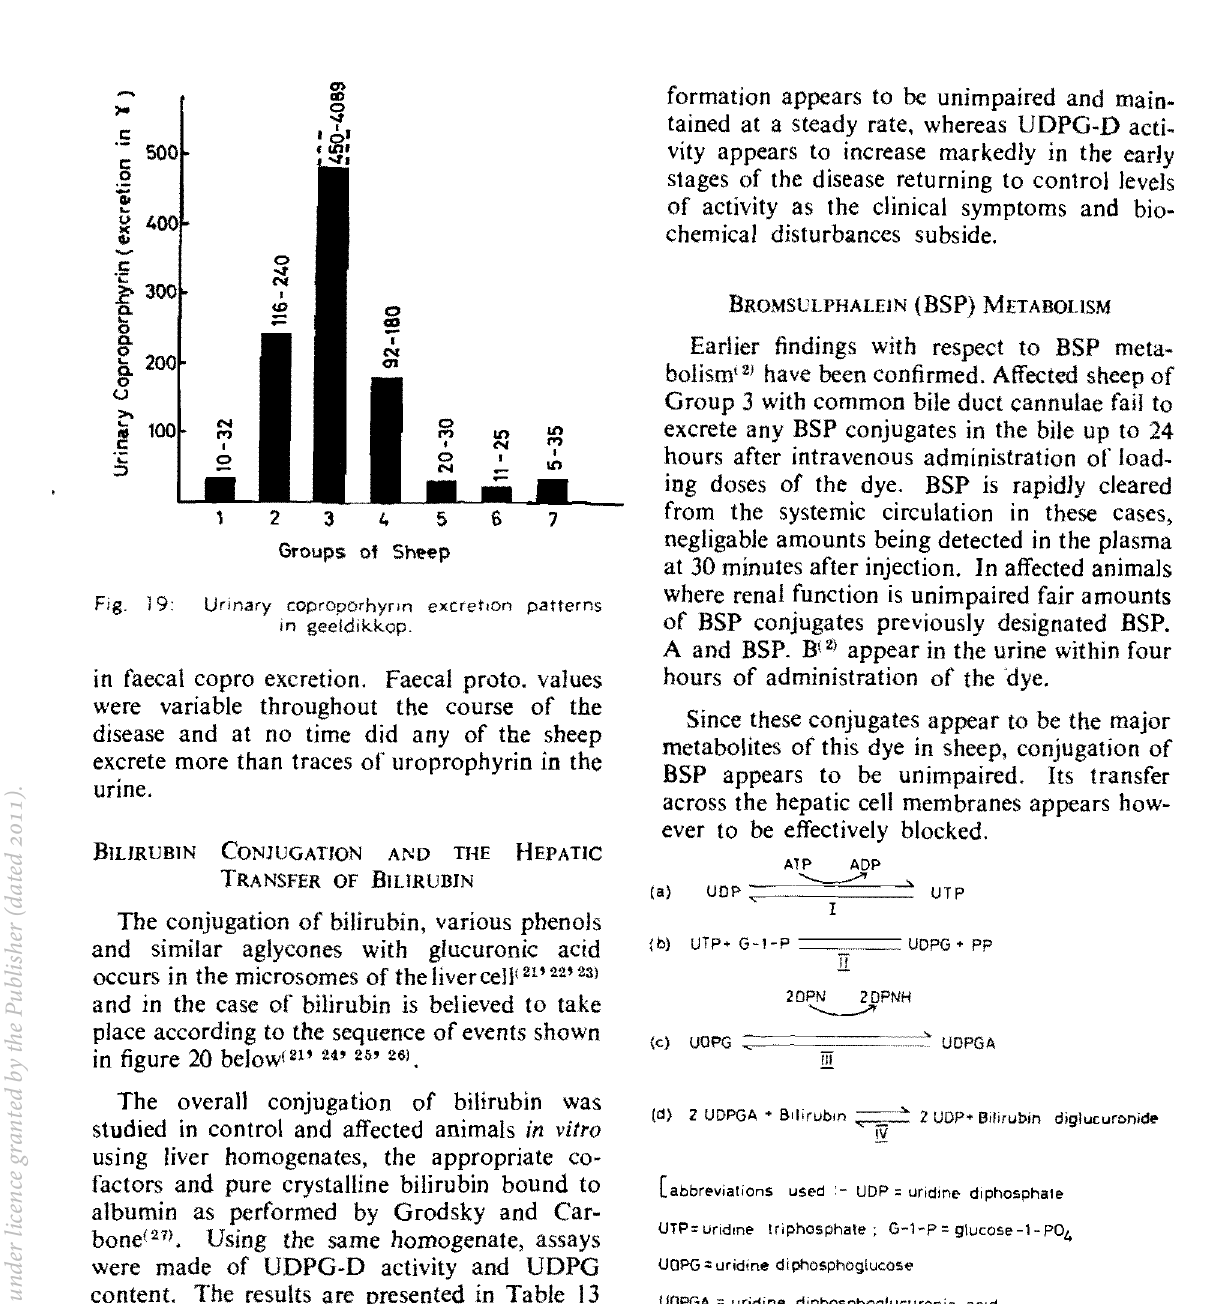
The mechanism of bilirubin conjugation in the